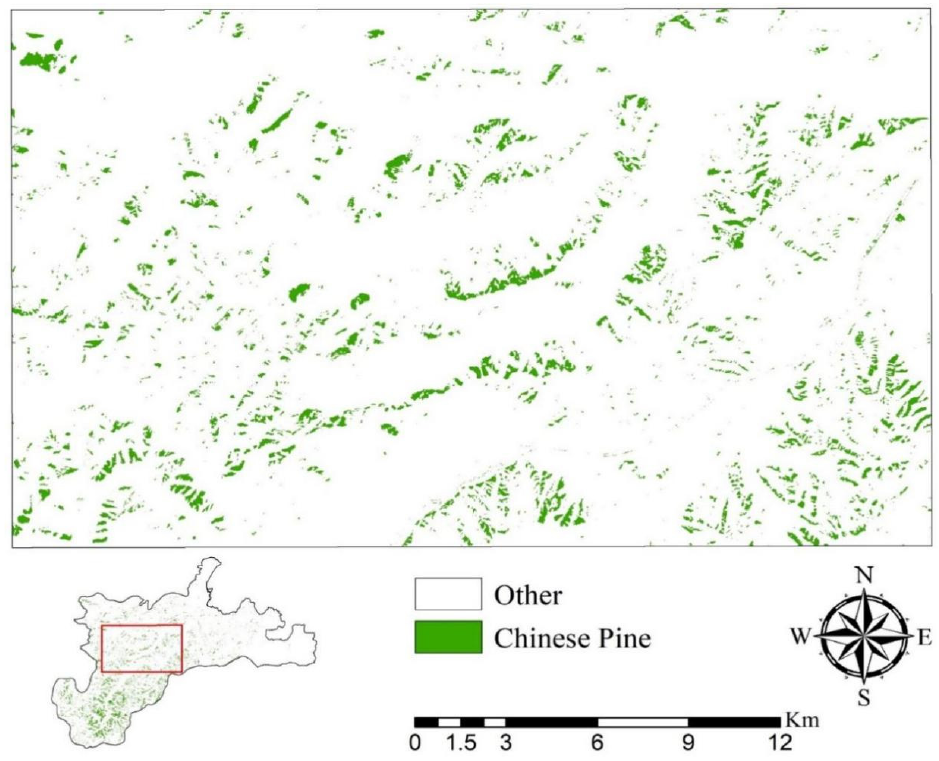
Figure 14. The extraction result of Chinese pine by DNN_S2_BI.